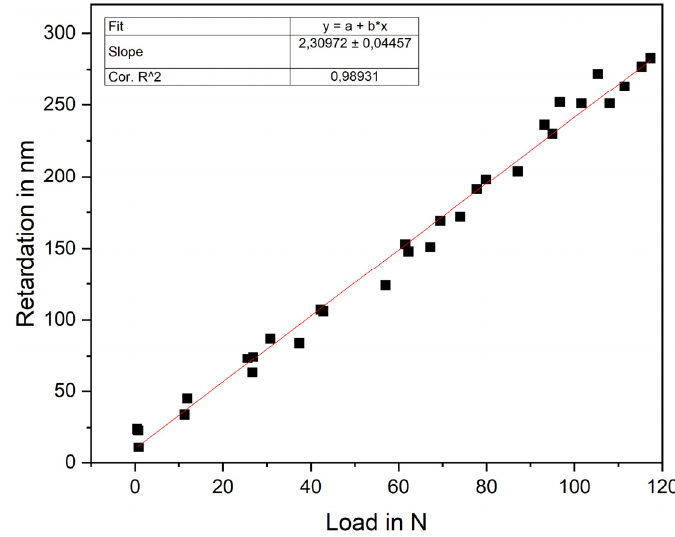
Figure 2. Photoelastic characterization of three rectangular epoxy resin references (27 × 3.15 × 3.15 mm 3 ) to measure the retardation dependent on the applied load. Determination of the gradient via a linear fit to calculate the stress-optical coefficient via Equation (1).